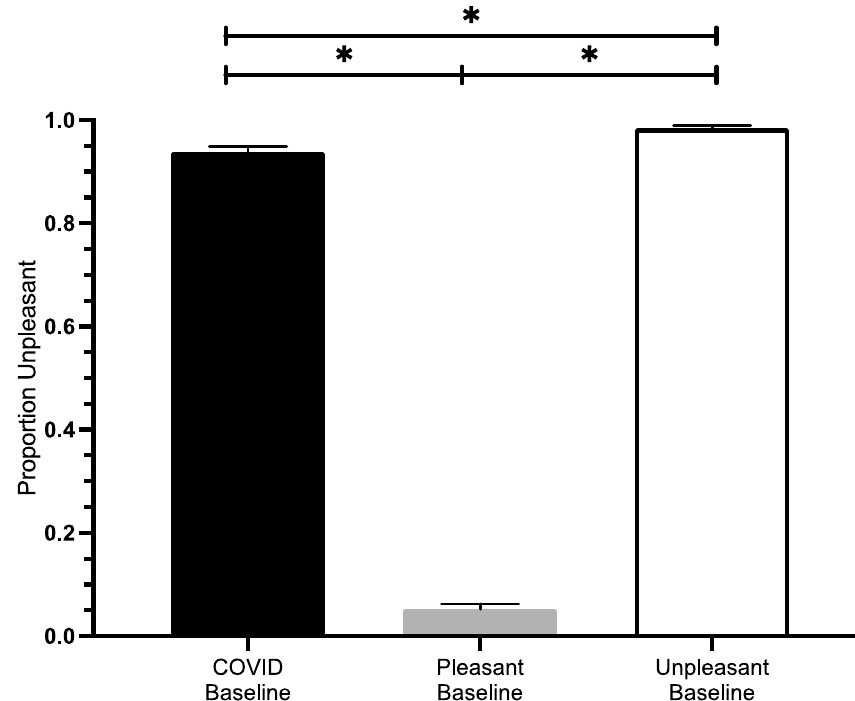
Figure 2. The proportion of unpleasant responses for each of the COVID-19 (black), pleasant (grey), and unpleasant (white) word categories. Both unpleasant and COVID-19 words were most often rated as unpleasant while pleasant words were rarely rated as